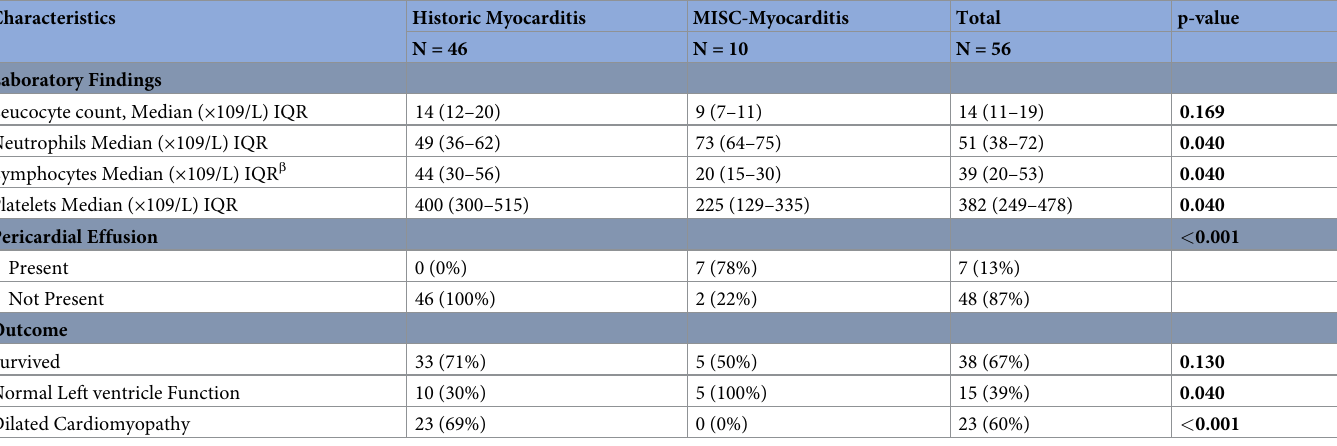
Table 4. Comparison of clinical and laboratory characteristics of historic and MIS-C viral myocarditis.